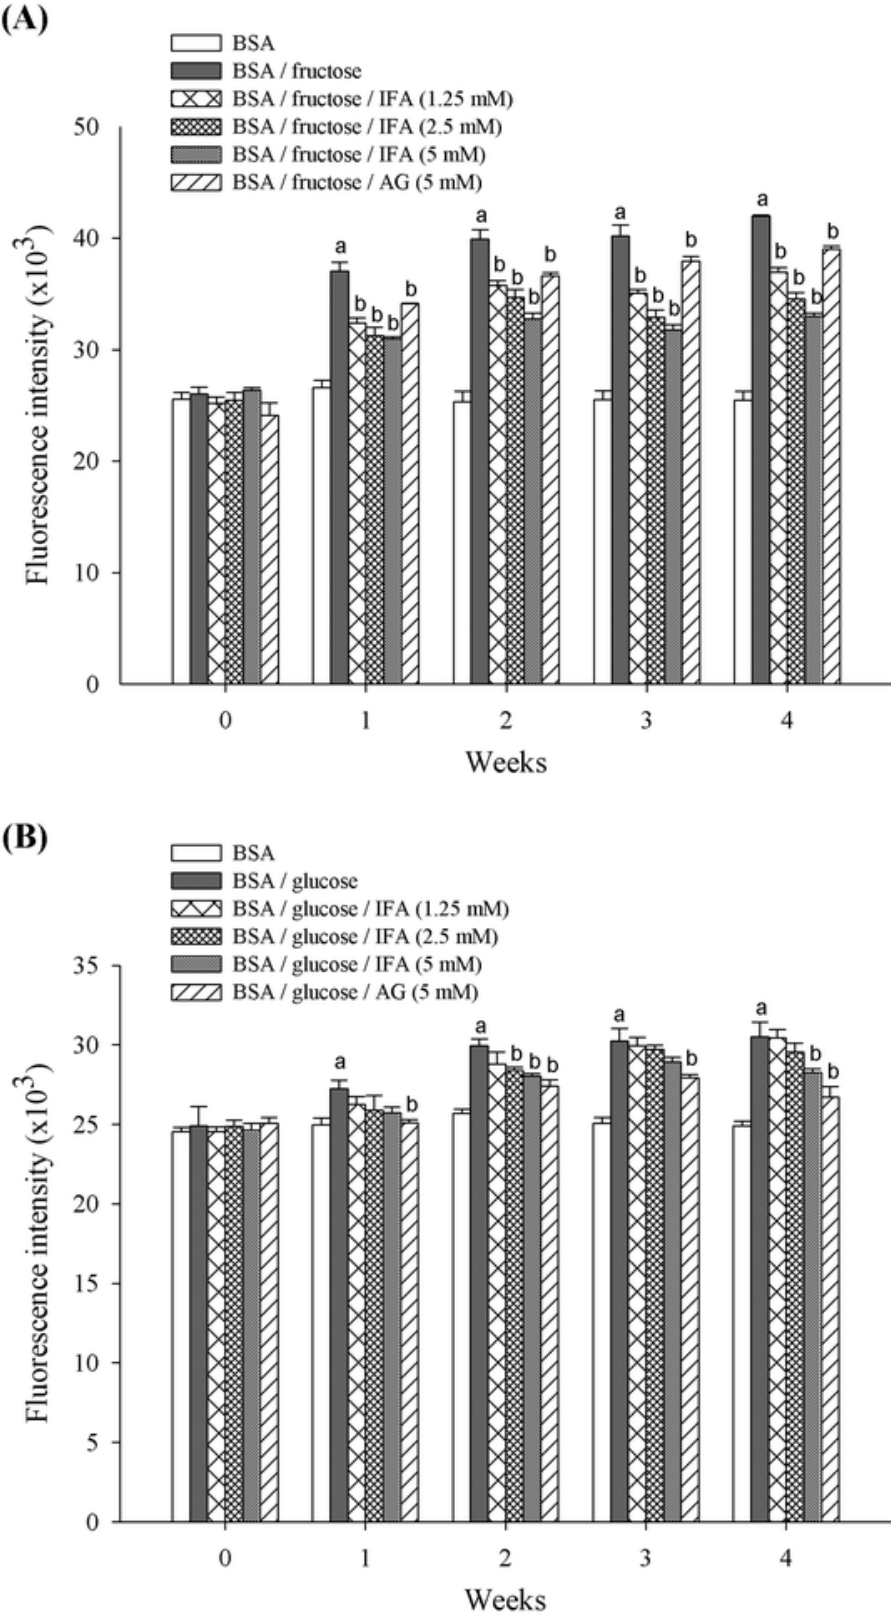
Figure 7. The effect of IFA on the amyloid cross β -structure of BSA/fructose ( A ) and BSA/glucose ( B ) systems. Results are expressed as mean ± SEM (n = 3). a p < 0.05 when compared to BSA, b p < 0.05 when compared to BSA/fructose or